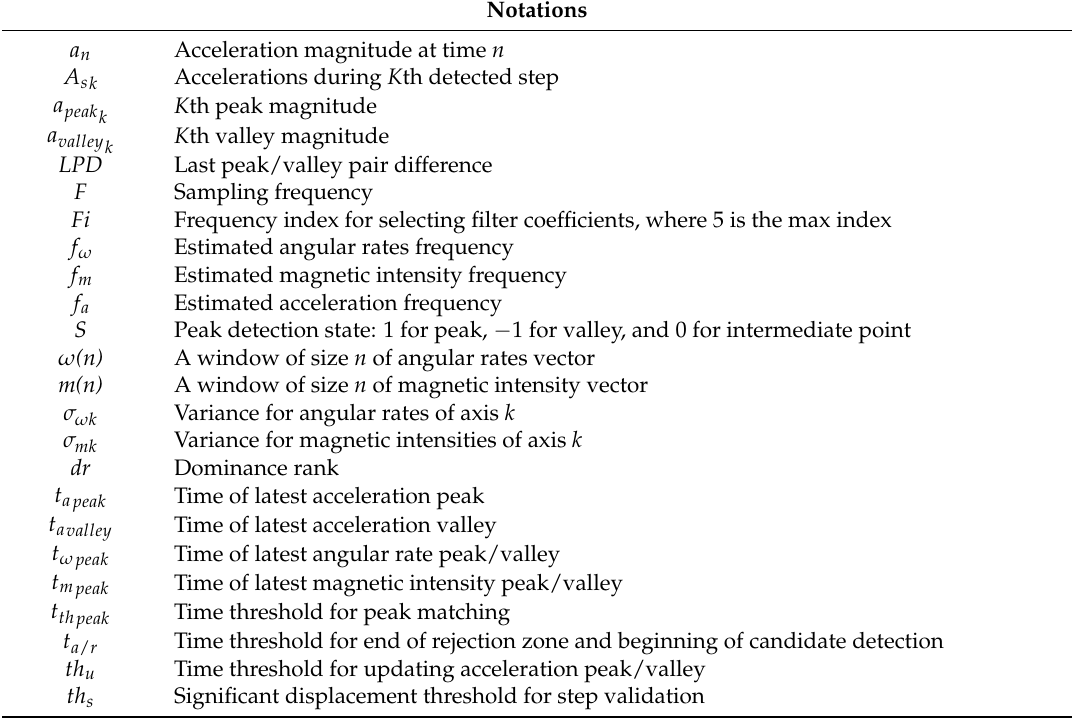
Table 1. List of variable notations used in the algorithm.